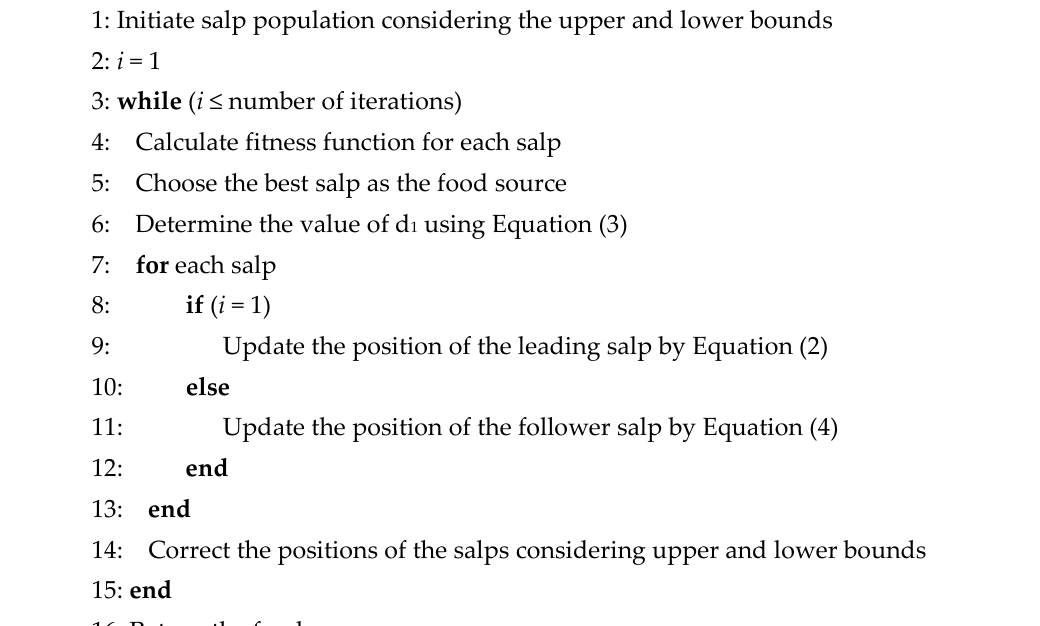
Algorithm 2. Pseudocode of